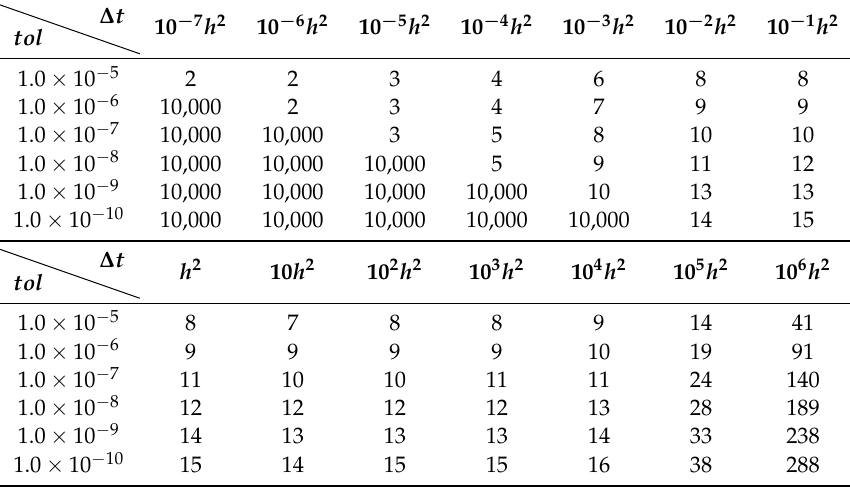
Table 7. Numbers of V-cycles for various tol and ∆ t after a single time